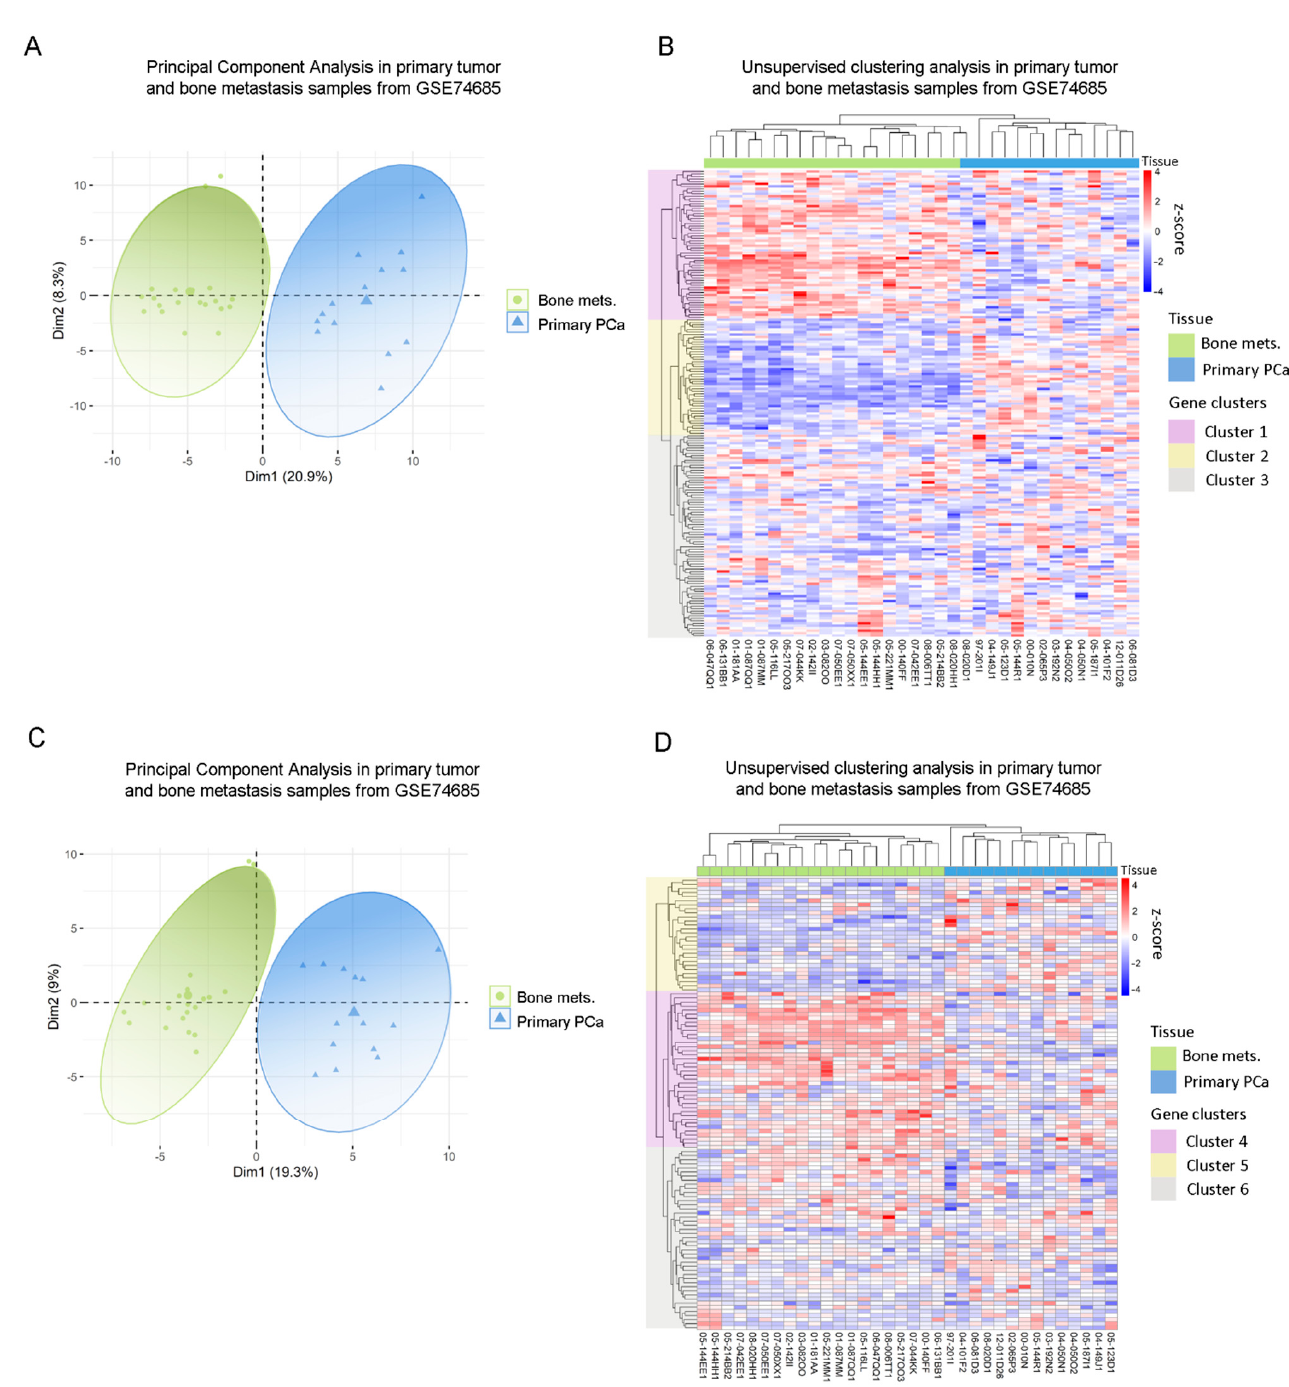
Figure 2. Clinical correlation of metabolic genes dysregulated in PC3 by the co-culture with bone progenitors. ( A ) Principal Component Analysis (PCA) biplot considering the expression of the metabolic genes identified in PC3 cells co-cultured with MC3T3 showing a rough segregation of primary tumors (blue) and bone metastases samples (green). Each point represents one sample from the GSE74685 dataset. ( B ) Heatmap depicting an unsupervised clustering analysis in human primary tumor and bone metastases samples, considering the expression of metabolic genes dysregulated in PC3 cells co-cultured with MC3T3 cells. ( C ) PCA biplot considering the expression of the metabolic genes identified in PC3 cells co-cultured with Raw264.7 showing a rough segregation of primary tumors (blue) and bone metastases samples (green). Each point represents one sample from the GSE74685 dataset. ( D ) Heatmap depicting an unsupervised clustering analysis in human pri- mary tumor and bone metastases samples, considering the expression of metabolic genes dysregu- lated in PC3 cells co-cultured with Raw264.7 cells. Red, white and blue colors represent higher, equal or lower z-score expression levels, respectively. Each green or blue box at the top of the heatmap represents a bone metastasis or primary tumor sample, respectively. Purple, yellow and